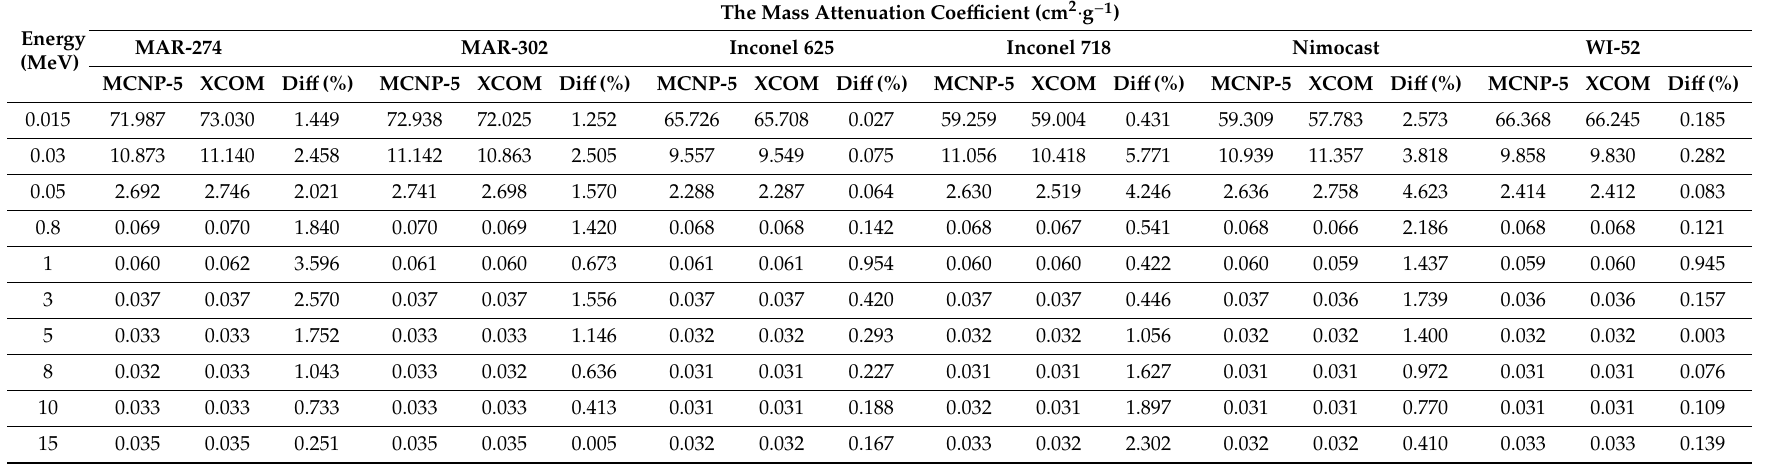
Table 2. The simulated and calculated mass attenuation coe ffi cients for the studied